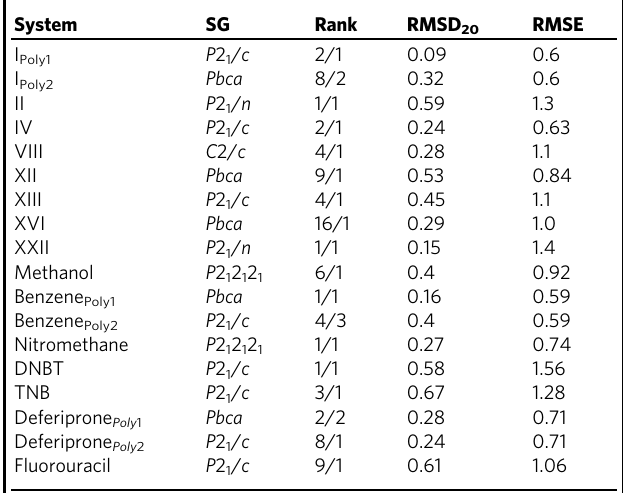
Table 1 CSPs from SAPT(DFT)-based aiFFs